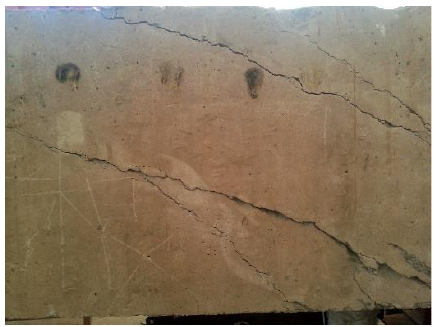
Figure 2. Cracks appeared on the proto beam.